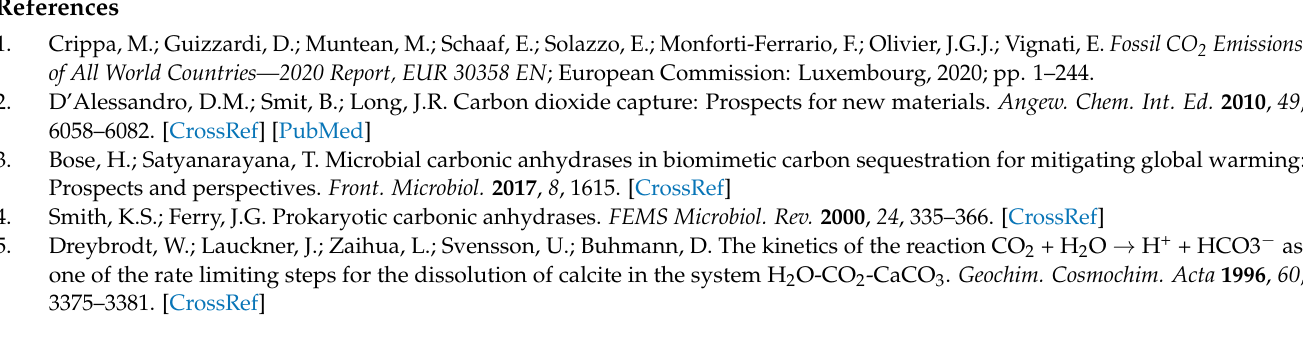
calcite; V: spherical